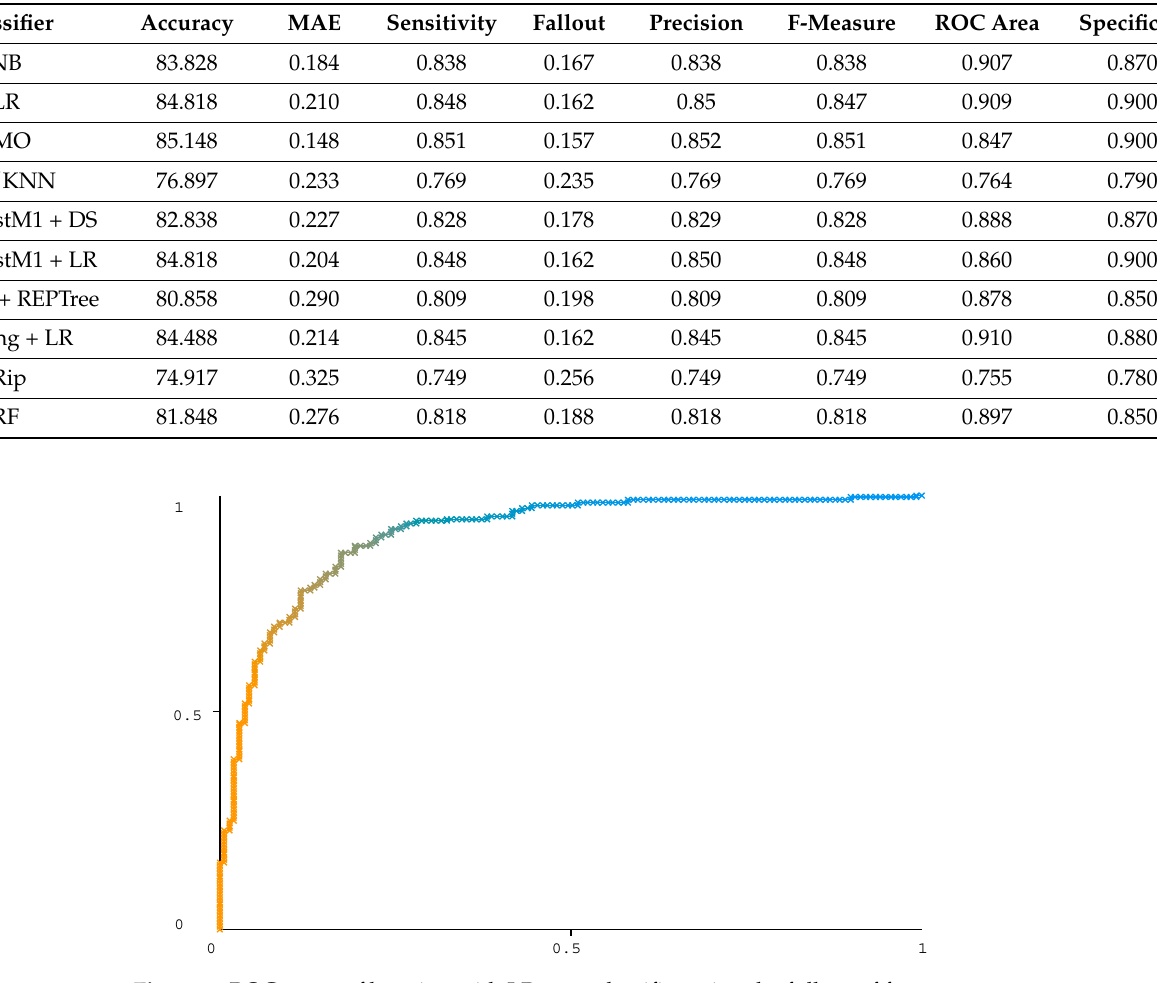
Figure 3. ROC curve of bagging with LR meta classifier using the full set of features.